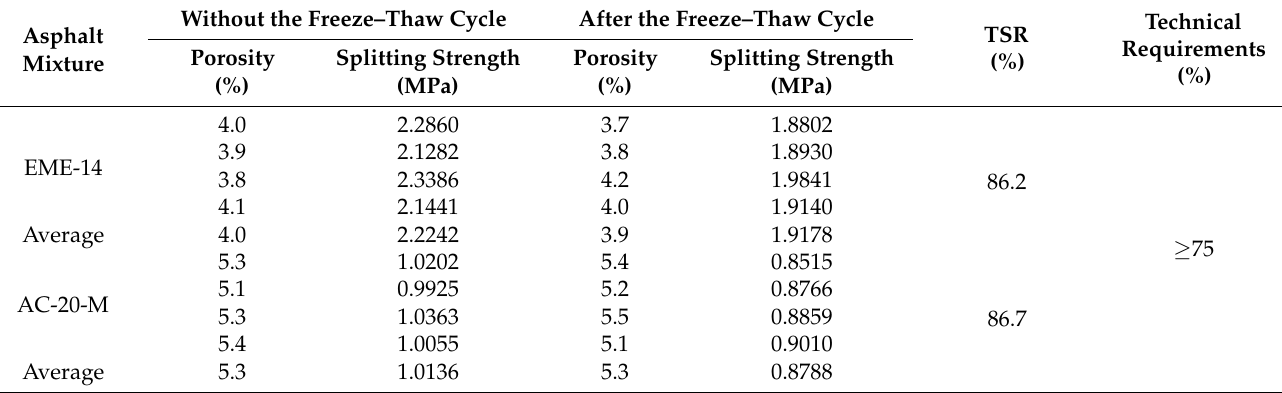
Table 7. Results of freeze–thaw splitting